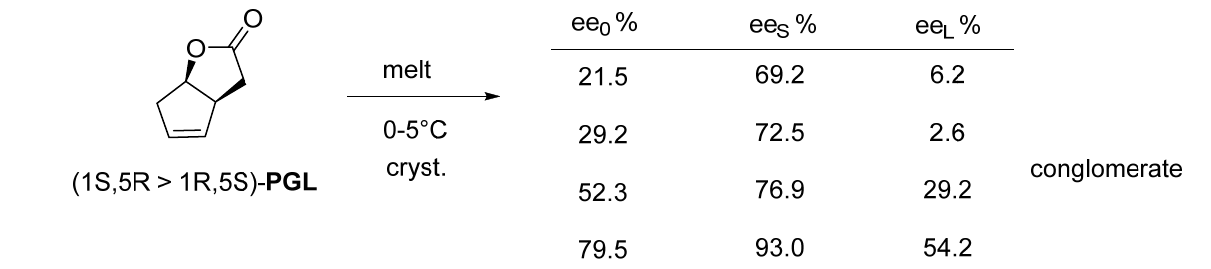
Figure 17. The common intermediate of prostaglandins can be purified by melt crystallization, the purer fraction always ends up in the crystalline phase. purer fraction always ends up in the crystalline phase.